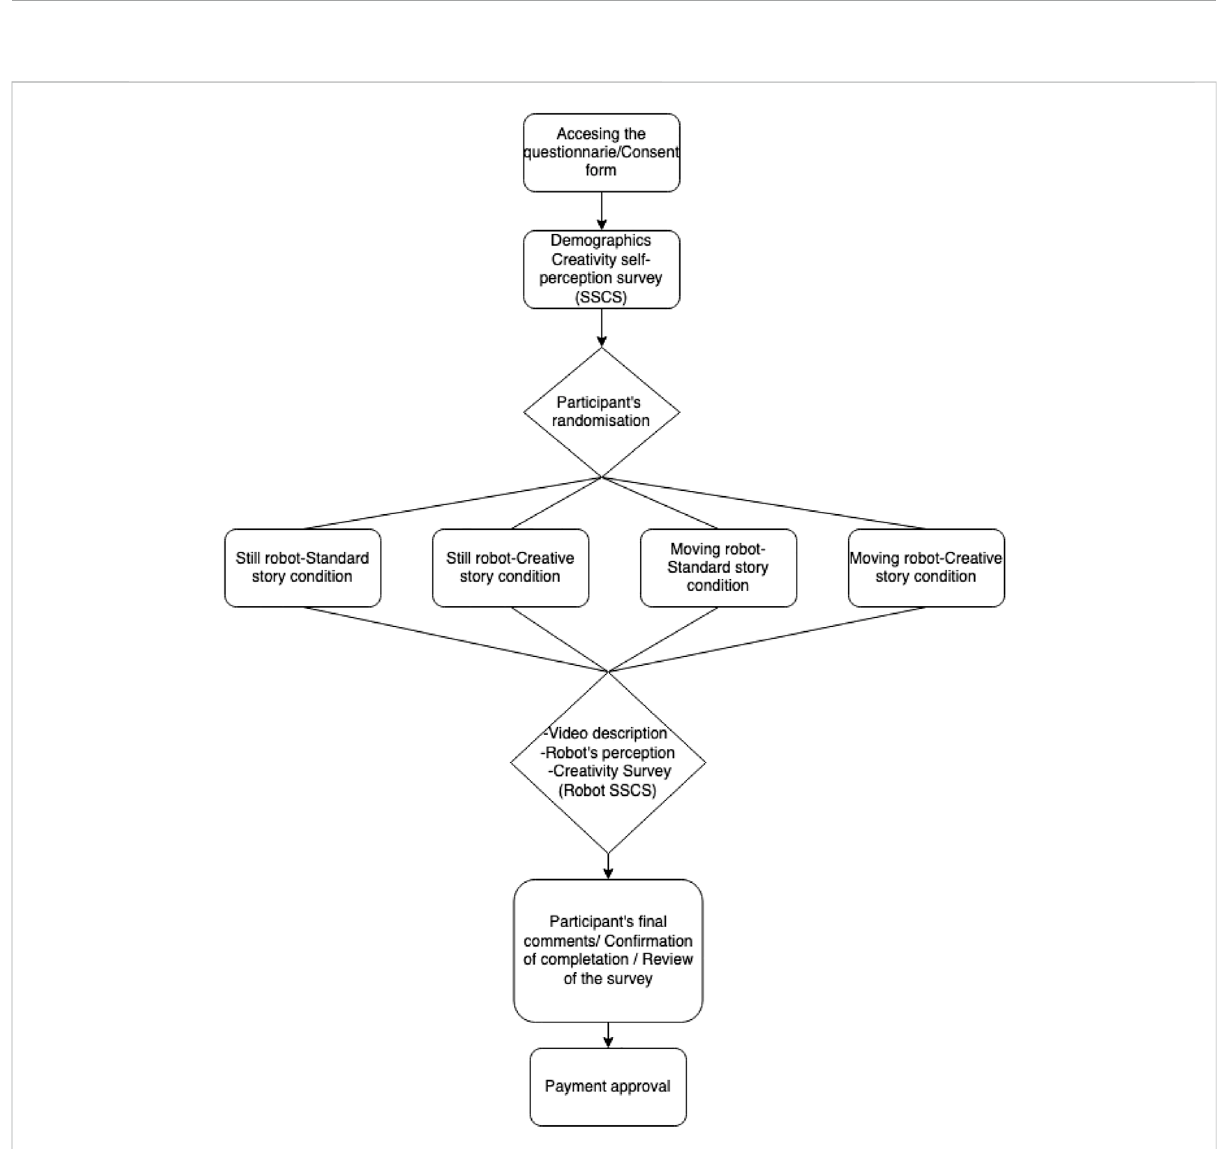
FIGURE 3 Experimental procedure. We applied the questionnaire using Qualtrics. We distributed it using Proli fi